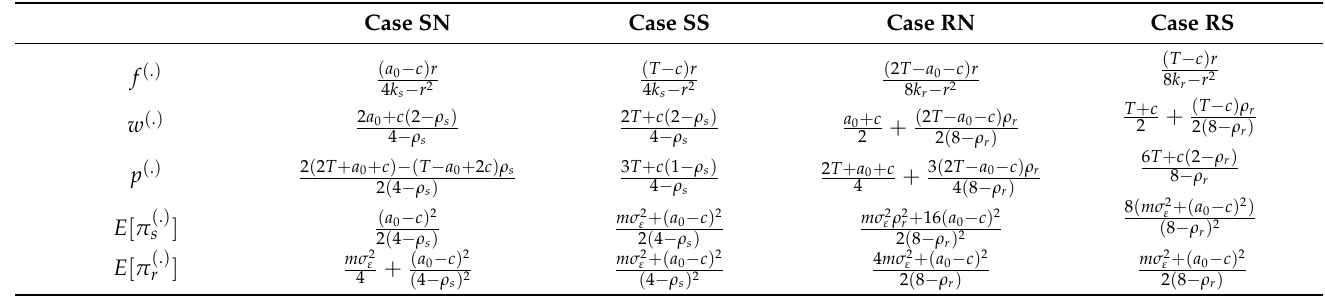
Table 3. The equilibrium results of four cases in the decentralized